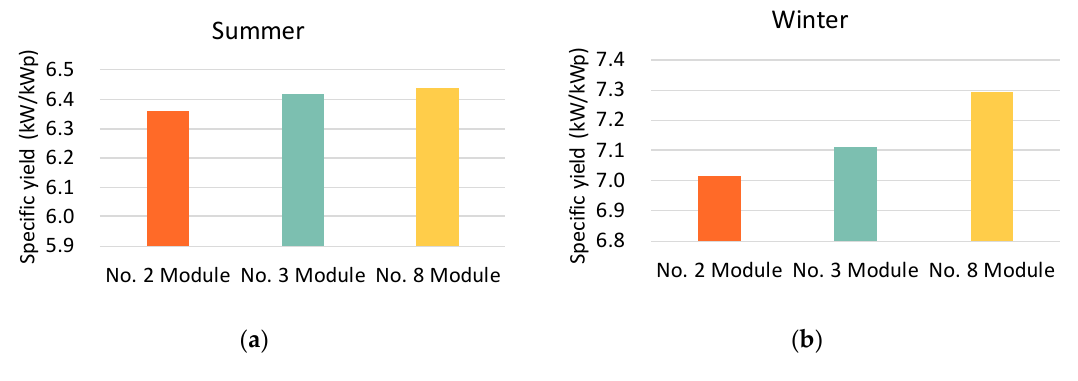
Figure 10. Daily specific yield comparison for the modules in the summer and winter: ( a ) daily specific yield on 6 August; ( b ) daily specific yield on 26 January.